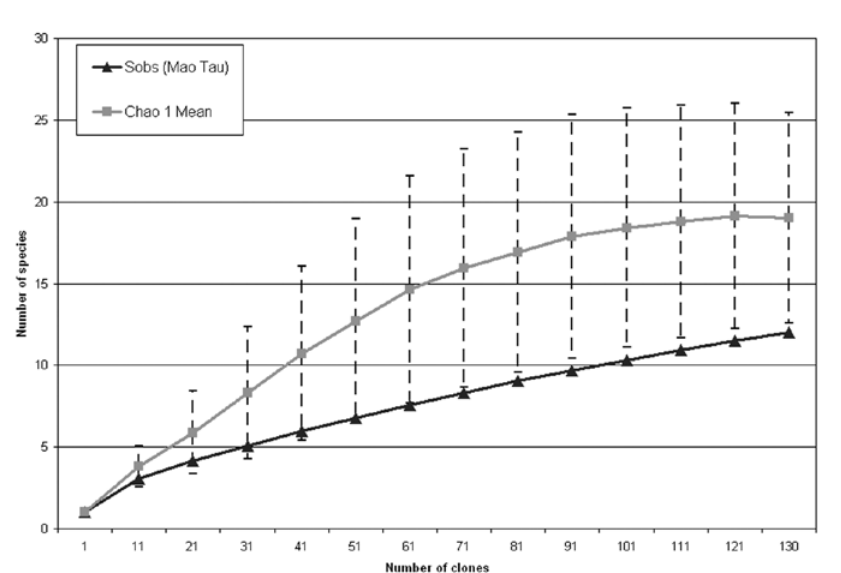
Fig. 1. species accumulation analysis of the 16s rDNA clone library from the lab-reared Bogalusa S. invicta